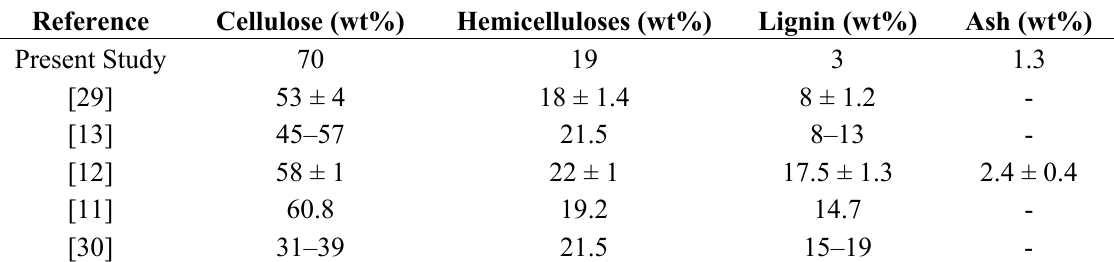
Table 1. Chemical composition of various kenaf fibers.